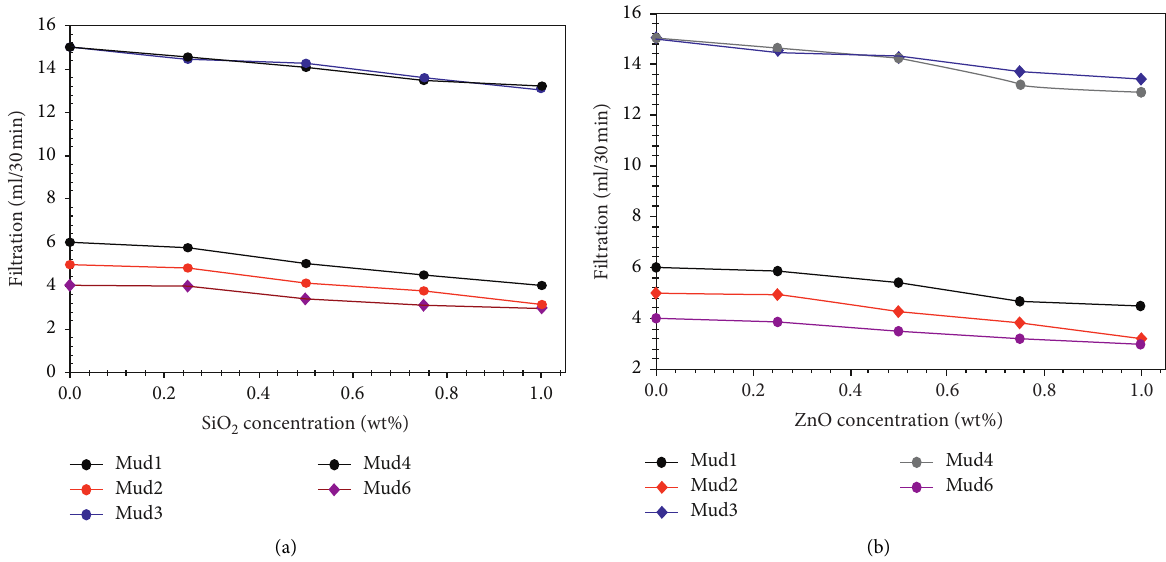
Figure 5: Effect of different concentrations of SiO 2 and ZnO NPs on mud filtration loss volume l by (a) adding SiO 2 NPs and (b) adding ZnO NPs to the drilling muds.